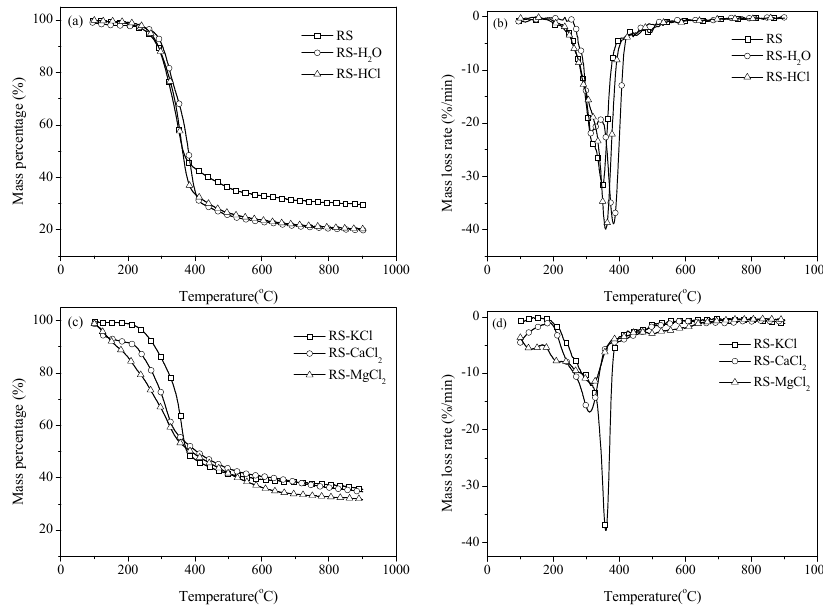
Figure 1. Thermal gravity (TG) and differential thermal gravity (DTG) curves of samples pyrolysis with a heating rate of 40 °C/min. ( a ) TG curves; ( b ) DTG curves; ( c ) TG curves with additives; ( d ) DTG curves with additives.